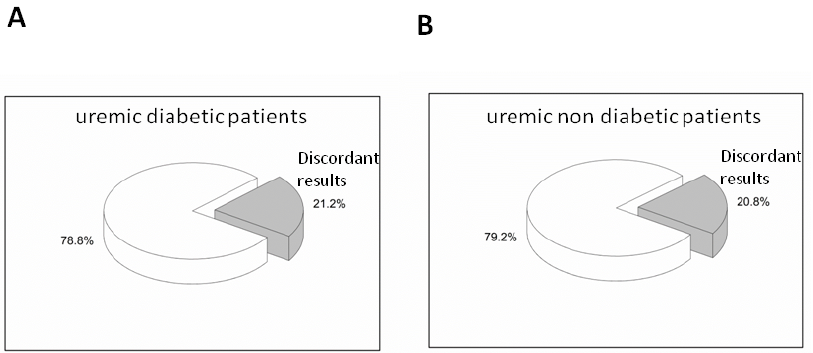
Figure 3. Discrepancies between the GA and HbA1c values in uremic diabetic (panel A ) and uremic non-diabetic (panel B ) patients. Abbreviations; GA, glycated albumin; HbA1c, glycated hemoglobin.